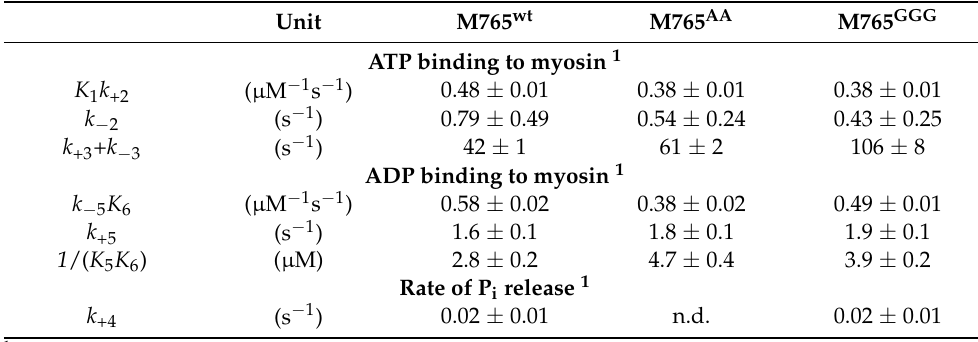
Table 3. Transient kinetic parameters and equilibrium constants in the absence of